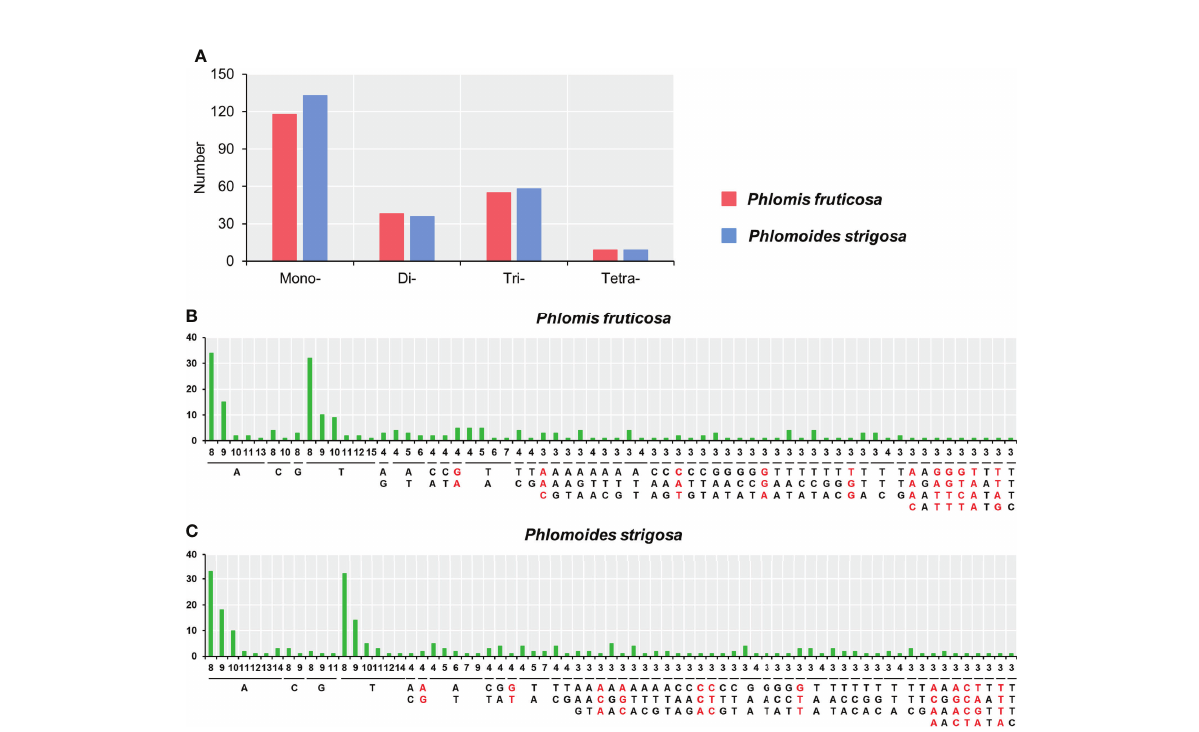
FIGURE 3 Analysis of simple sequence repeats in chloroplast genomes of Phlomis fruticosa and Phlomoides strigosa . Simple sequence repeats (SSRs) were analyzed in Phlomis fruticosa and Phlomoides strigosa . (A) Statistics of four types of SSRs in P. fruticosa and P. strigosa . (B, C) The x-axis represents the nucleotide units of each SSR, and the numbers of units within each SSR. The y-axis represents the numbers of each SSR in the chloroplast genome. SSRs unique to P. fruticosa or P. strigosa are marked in red. Mono-, mono-nucleotide repeat; Di-, di-nucleotide repeat; Tri-, tri-nucleotide repeat; Tetra-, tetra-nucleotide